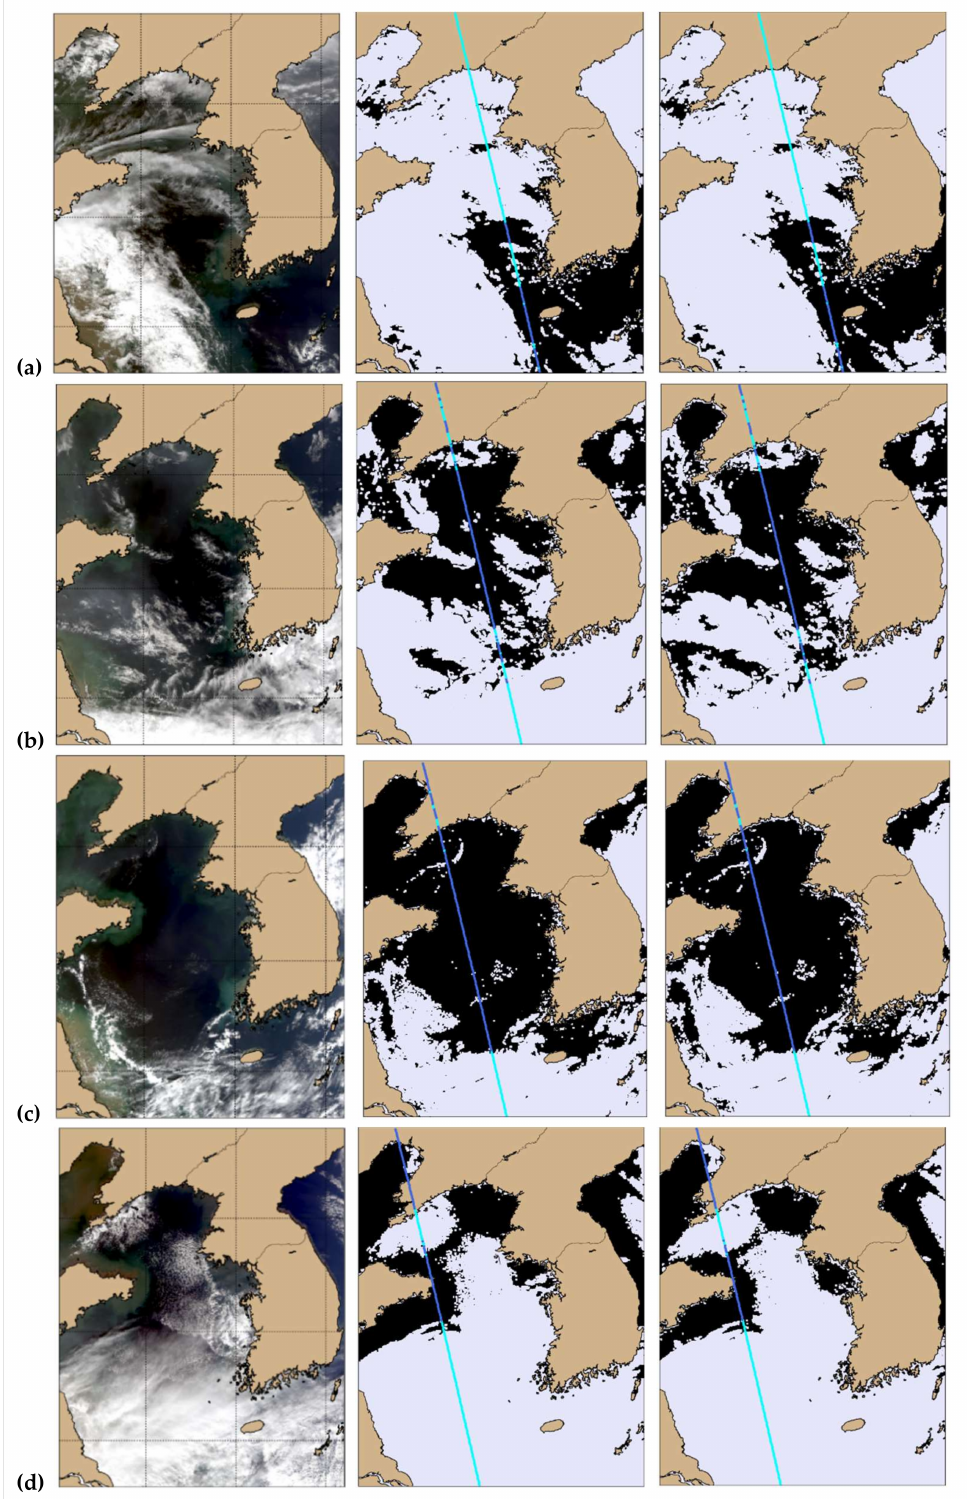
Figure 9. ( a ) spring case: 25 March 2020 (05:05 UTC (MODIS) and 05:14 UTC (CALIPSO)); ( b ) summer case: 15 July 2020 (05:05 UTC (MODIS) and 05:21 UTC (CALIPSO)); ( c ) autumn case: 26 September 2020 (05:00 UTC (MODIS) and 05:27 UTC (CALIPSO)); ( d ) winter case: 16 January 2021 (05:00 UTC (MODIS) and 05:28 UTC (CALIPSO)). The first, second, and third rows indicate the MODIS RGB image, the proposed CM, and MODIS CM, respectively. CALIPSO laser footprints are overlaid in the second and third columns where cyan and blue colors indicate cloud or no cloud pixels,